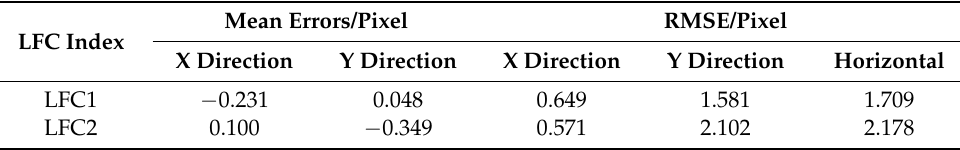
Table 2. Residuals after external calibration of laser footprint cameras